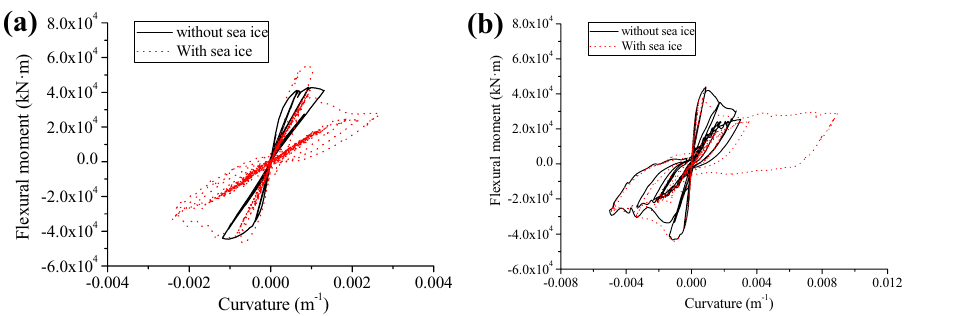
Figure 6. Bending moment and curvature hysteresis curves of the wind turbine tower bottom: ( a ) T1-II-1; ( b ) T2-II-1.